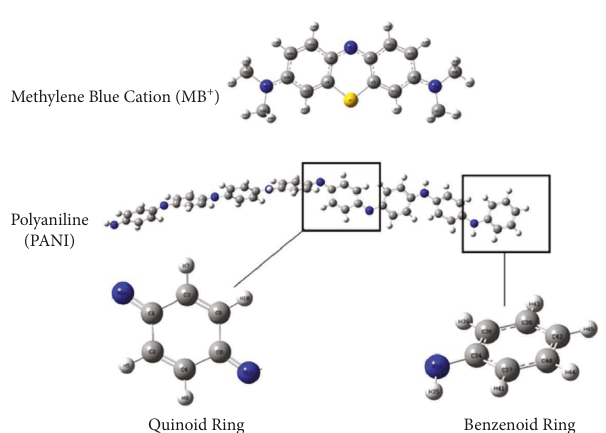
Figure 1: Structure representation of MB and quinoid and ben- zenoid rings of PANI. Nomenclature: carbon is indicated in grey, nitrogen in blue, hydrogen in white, and sulfur in